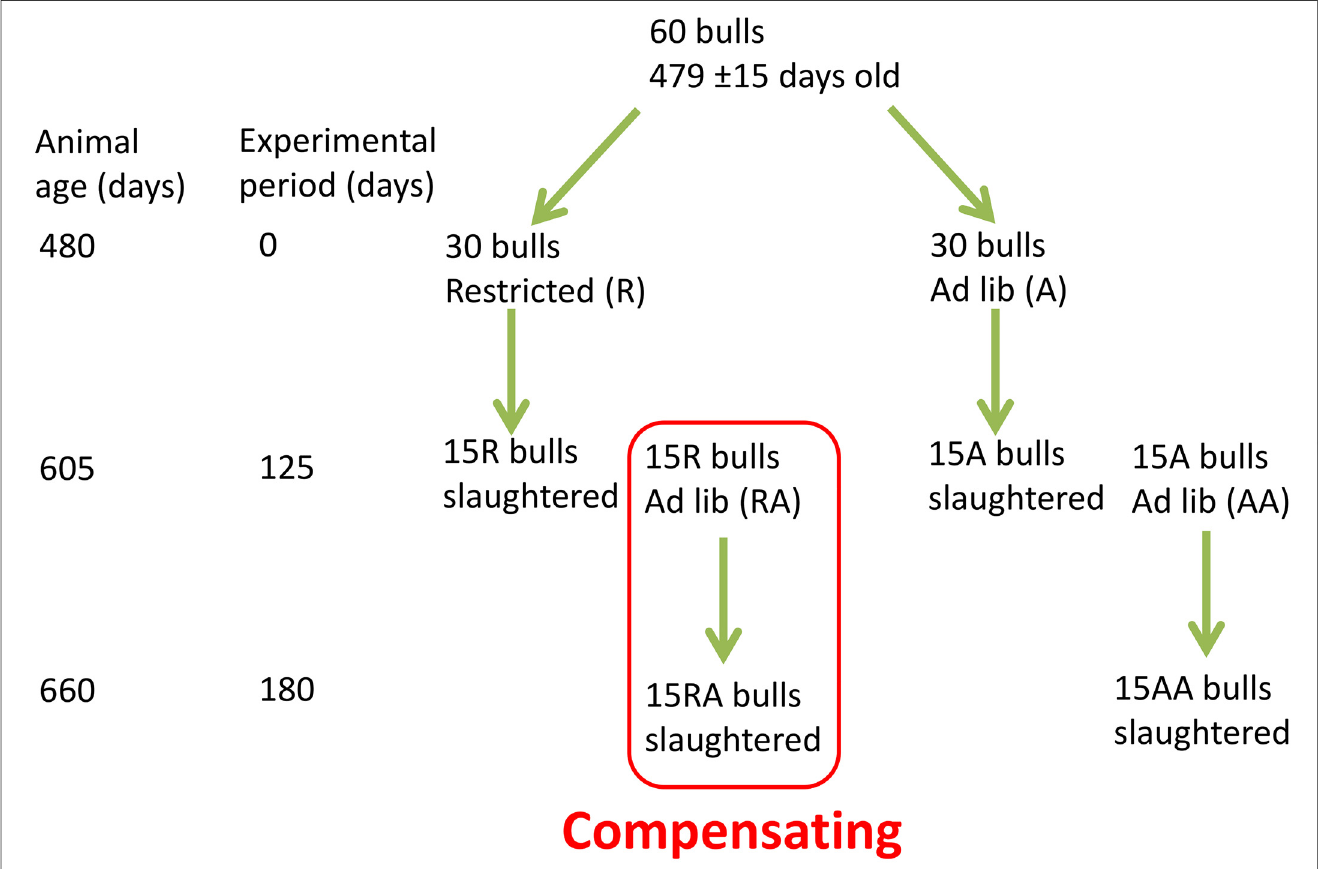
Fig 1. Scheme of compensatory growth animal